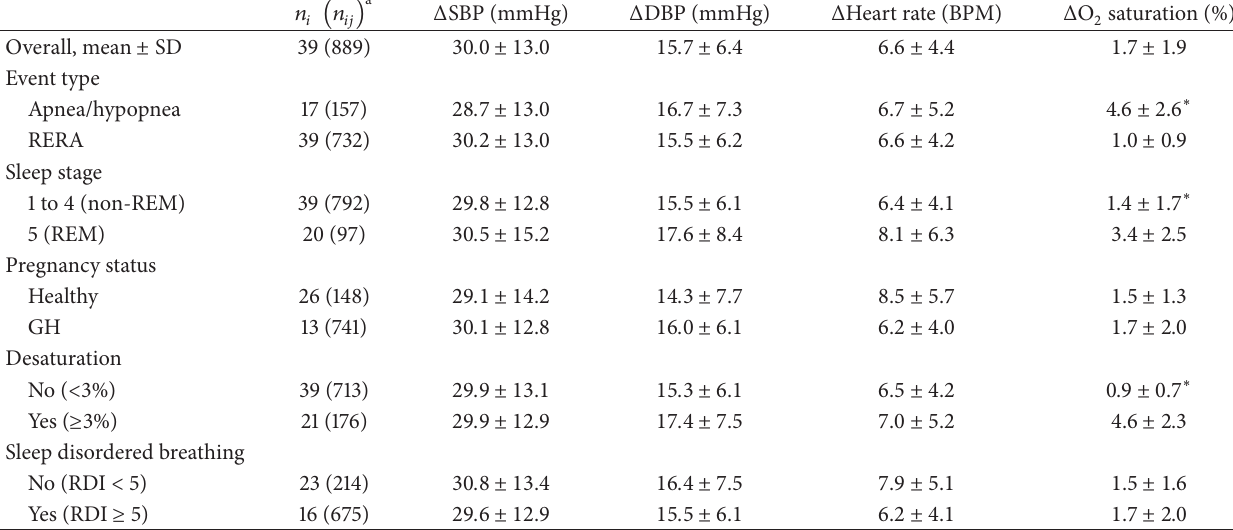
Table 2: Hemodynamic responses to apnea, hypopnea, or RERA breathing events.